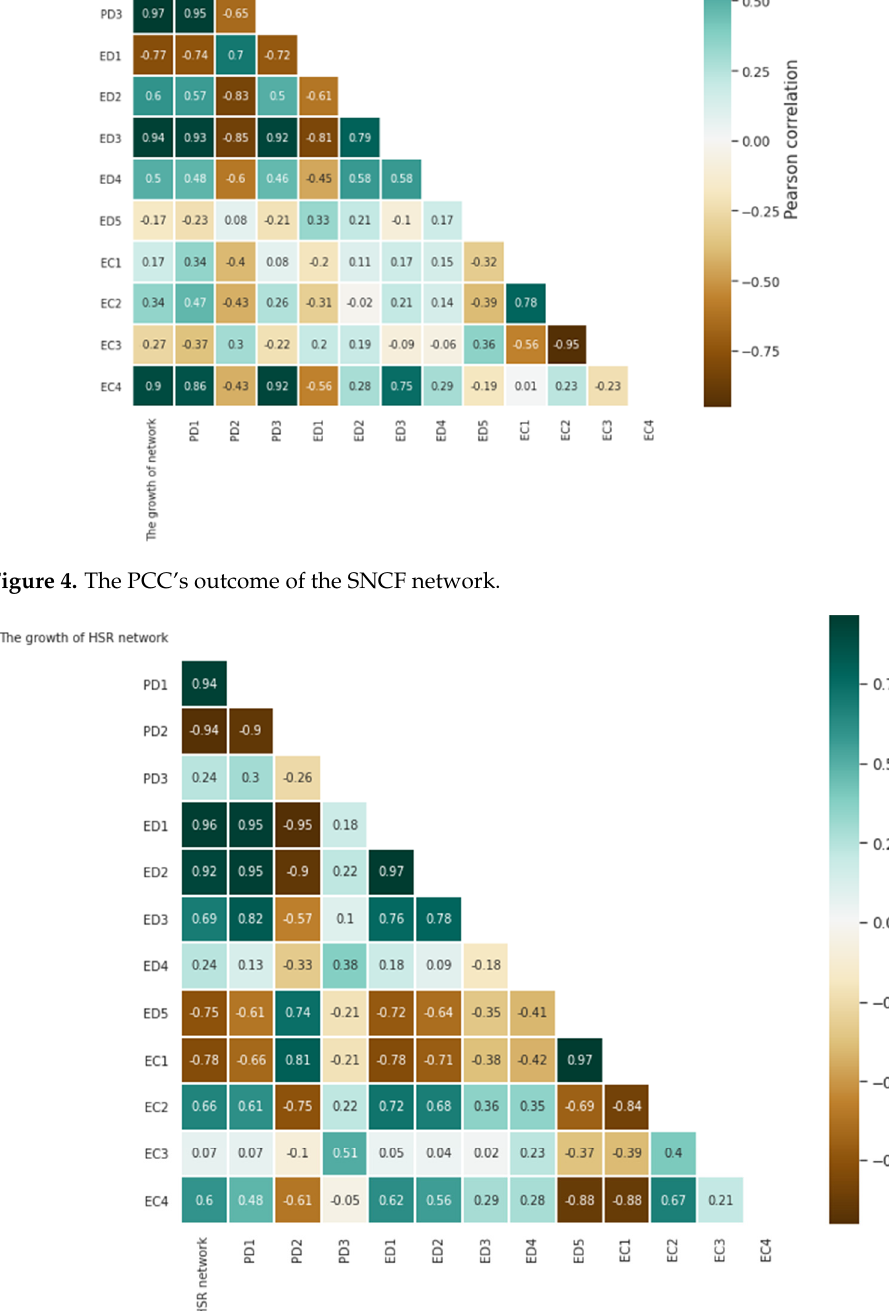
Figure 5. The PCC’s outcome of the JR Central network